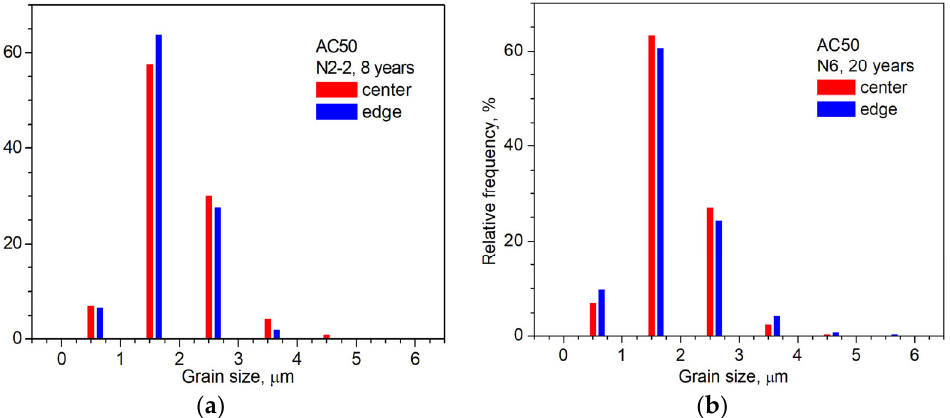
Figure 3. Histograms of grain size distribution for the centers and edges of cross ‐ sections of outer wires from the AC50 cables after ( a ) 8 years of service (N2 ‐ 2) and ( b ) 20 years of service (N6). For better visualization, the histograms for sample edges are shifted along the abscissa axes in ( a , b ).